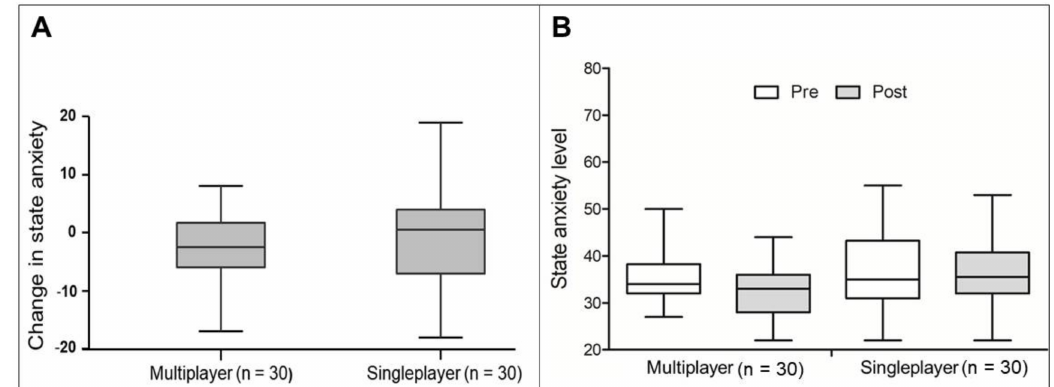
Figure 2. State anxiety and exergame. ( A ) Comparison of the state anxiety level changes after a session of the exergame Kinect Sports ® beach volleyball between the single and multiplayer modes. There is no significant difference between modes ( p -value = 0.407). ( B ) Comparison of the state anxiety level before and after a session of the exergame Kinect Sports ® beach volleyball between the single and multiplayer modes. There is no significant difference in the single-player ( p -value = 0.516) and multiplayer ( p -value = 0.053) modes.